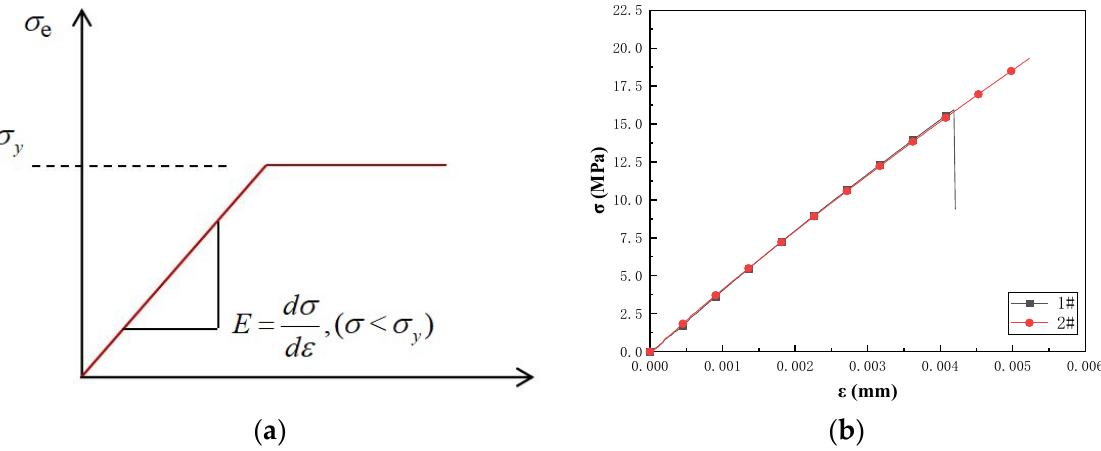
Figure 11. The verification of material model constitutive equation. ( a ) Constitutive equation curves of the material model. ( b ) Stress–strain curves of samples 1# and 2#.